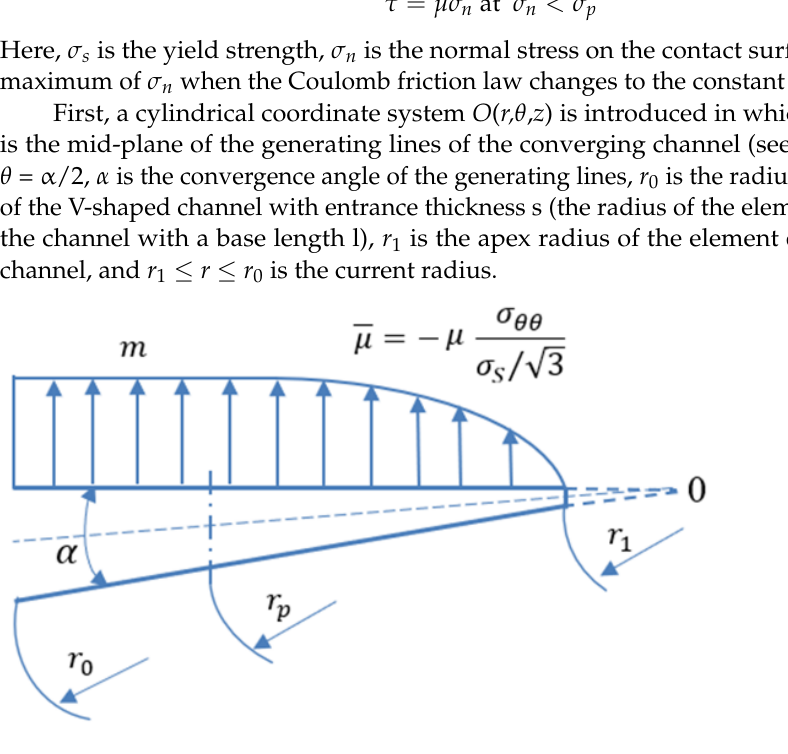
Figure 1. Scheme of the determination of the Coulomb constant shear friction law coefficients. α —convergence angle, r 0 —radius of the generatrix of the V-shaped channel, r 1 —apex radius of the element extruded into the channel, r p —transition area radius from constant to Coulomb friction law. λ = r 0 is the elongation ratio of the extruded element, and λ l = l is the relative length r 1 s of the extruded element to make a transition to dimensionless